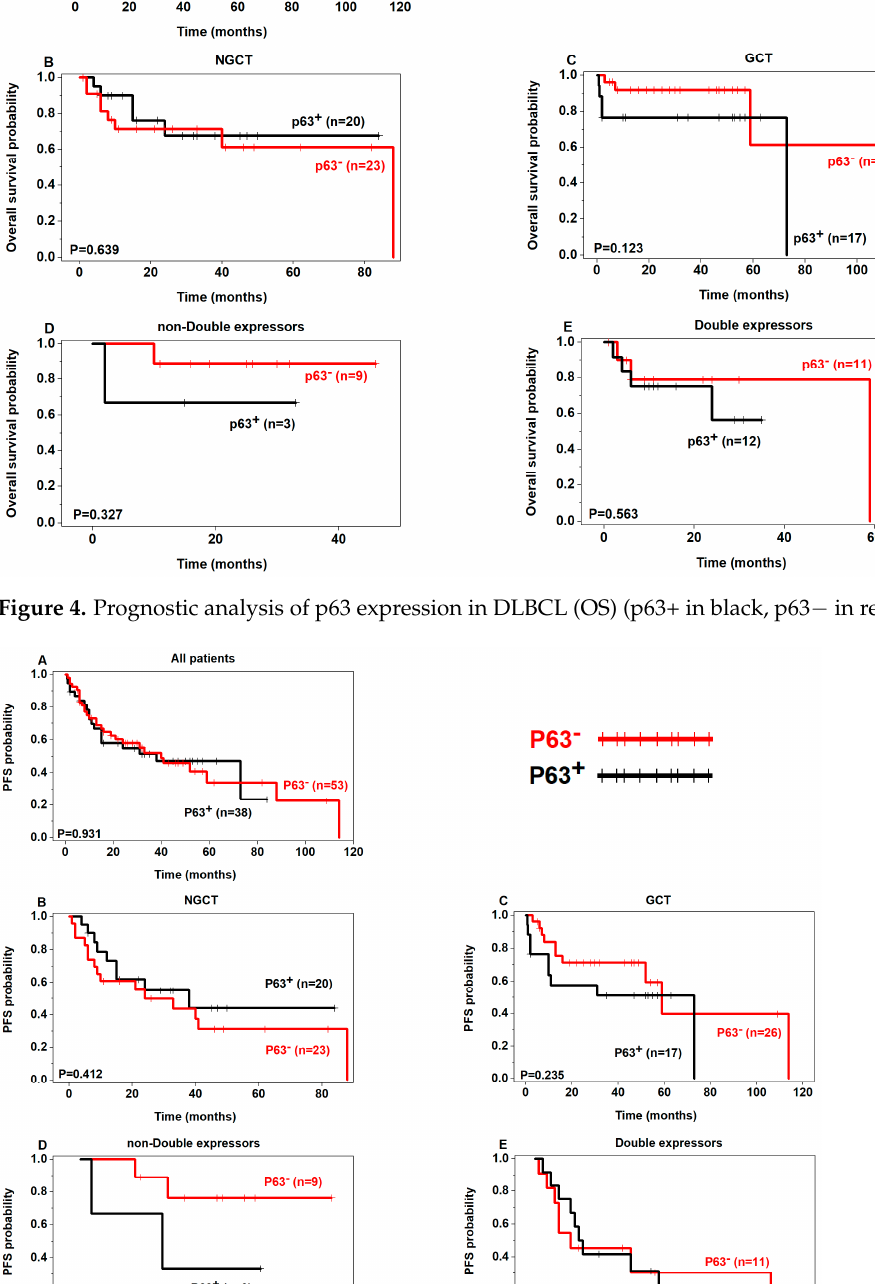
Figure 5. Prognostic analysis of p63 expression in DLBCL (PFS) (p63+ in black, p63 − in red).